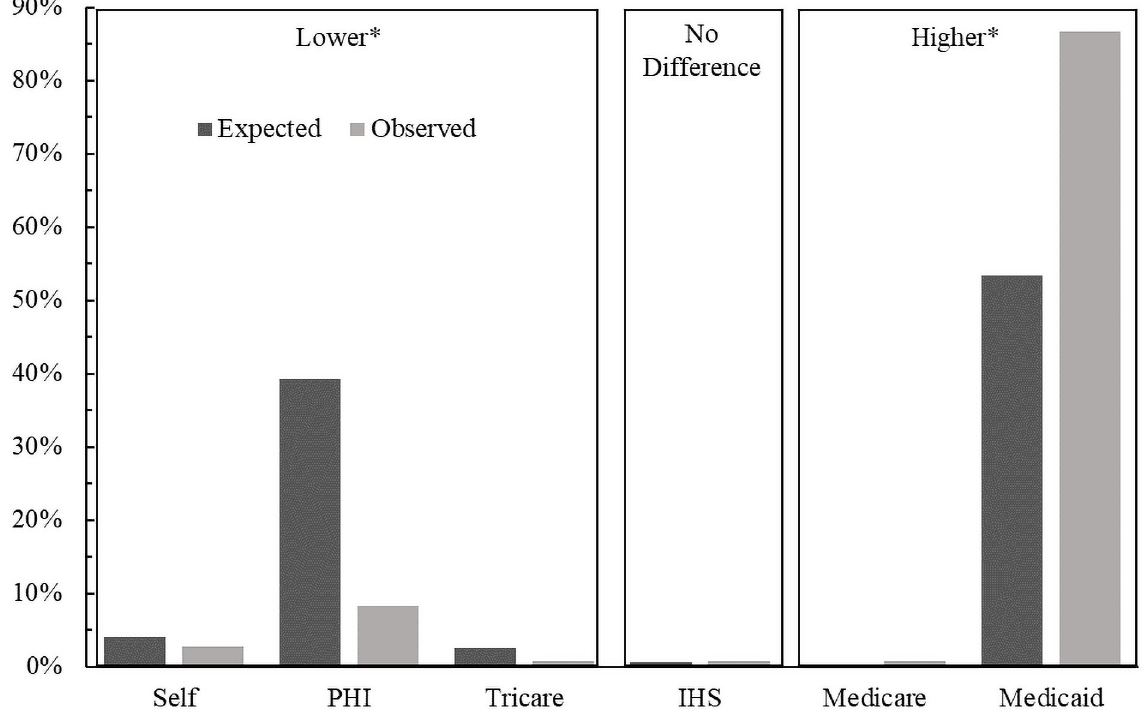
Fig 4. Comparison of the observed versus expected proportions of NOWS at the time birth in each payor group utilized for infants. Boxes labelled higher or lower mean that the observed proportions are significantly higher or lower than the expected proportion after post-hoc comparisons that incorporate a Bonferroni correction with six groups (p < 0.001/6). PHI: Private Health Insurance, Self: Self Pay, IHS: Indian Health